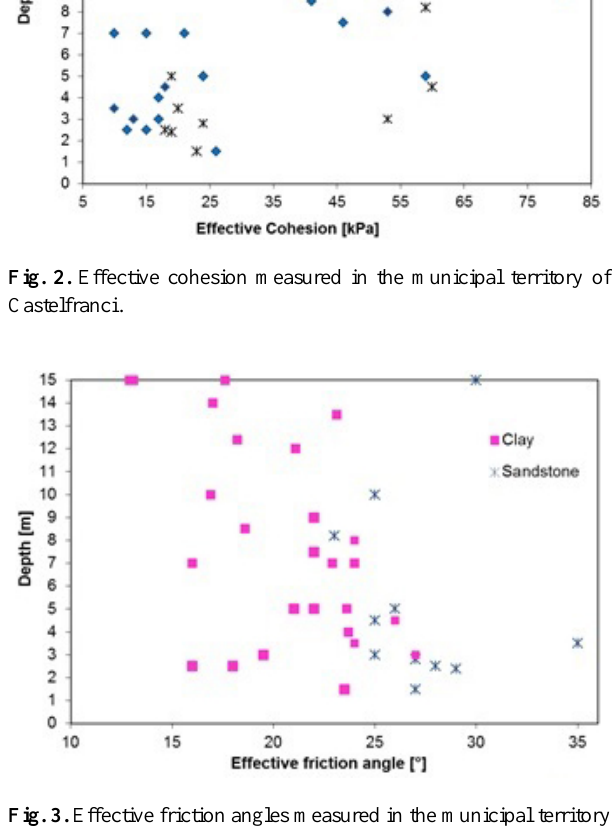
Fig. 3. Effective friction angles measured in the municipal territory of